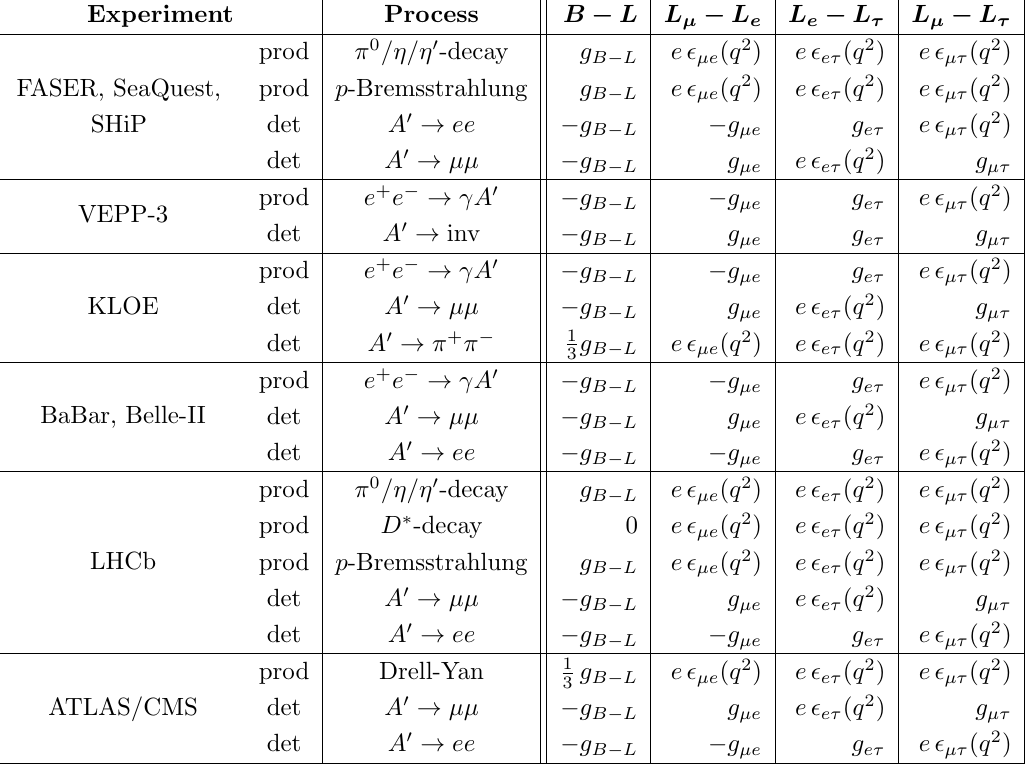
Table 3 . Coupling strengths for the di(cid:11)erent gauge groups relevant for the production and decay of hidden photons in experiments discussed in this paper compared to the universal e (cid:15) Q EM coupling of the secluded hidden photon.